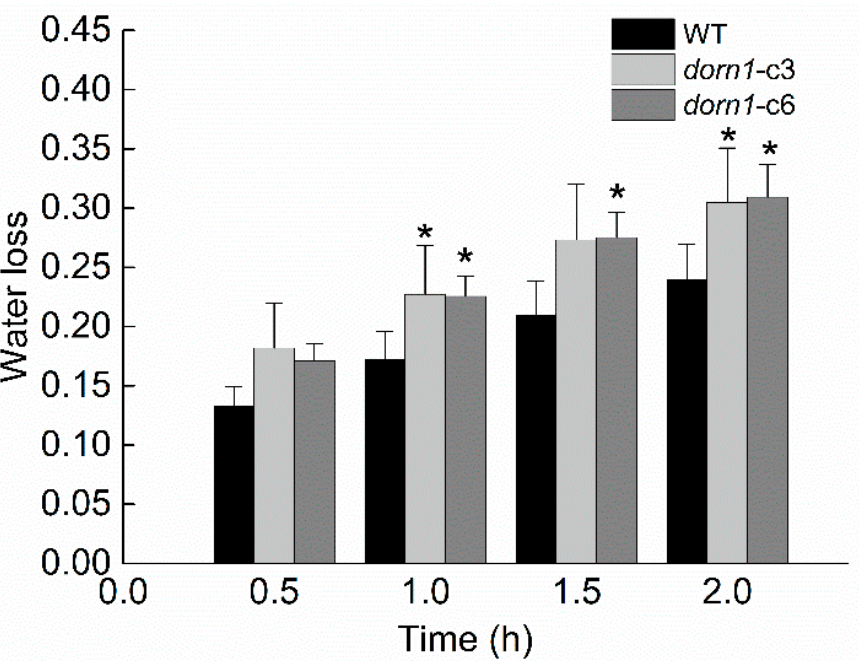
Figure 5. The transpirational water loss of the dorn1 and WT plants. Mutant and WT plants are grown on soil for 21 days, then the water loss rate is measured and analyzed. Each data point represents the average water loss of ~15 seedlings of three duplicate experiments, and error bars represent the standard deviation (SD). “*“ indicate significant differences ( p < 0.05) using Tukey’s analysis.